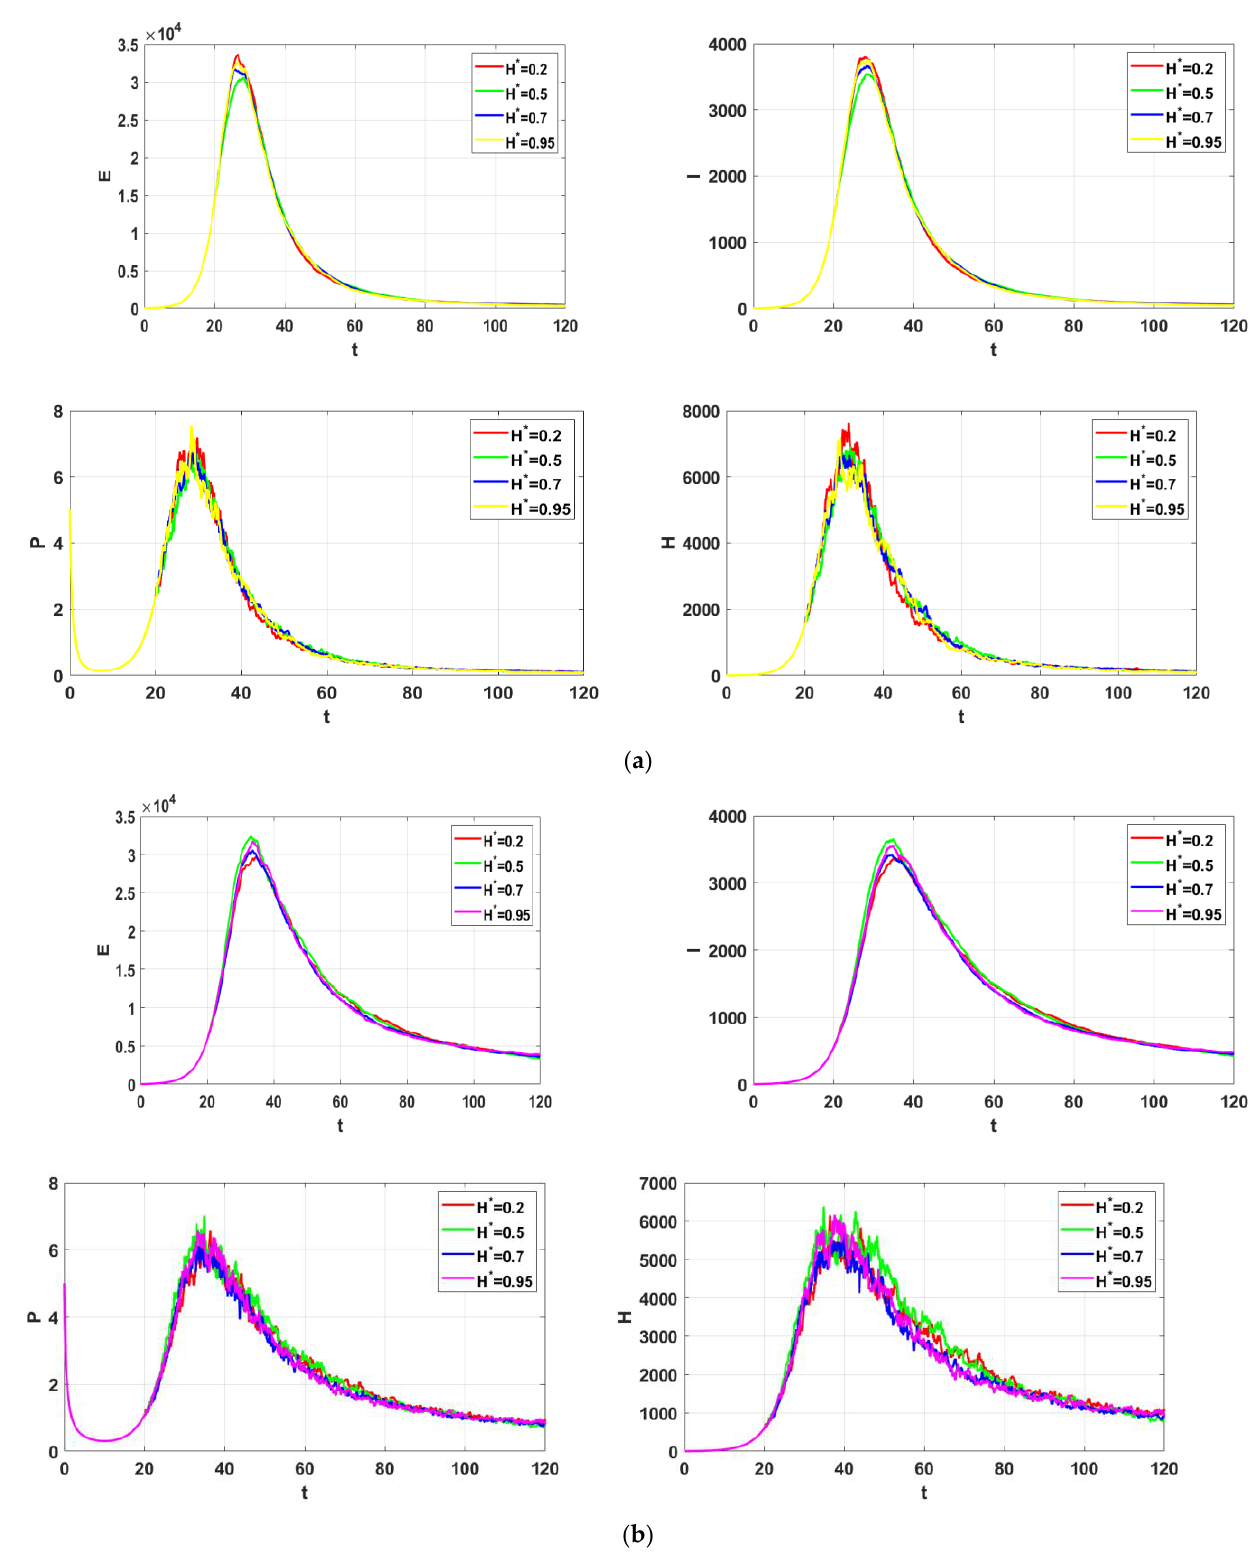
Figure 10. Numerical simulation for system (14–16) at different H ∗ , and ( a ) α = 0.9, α 1 = 0.87, ( b ) α = 0.75, α 1 = 0.75, σ 1 = σ 2 = σ 3 = 0.01, σ 4 = σ 5 = σ 6 = σ 7 = σ 8 =